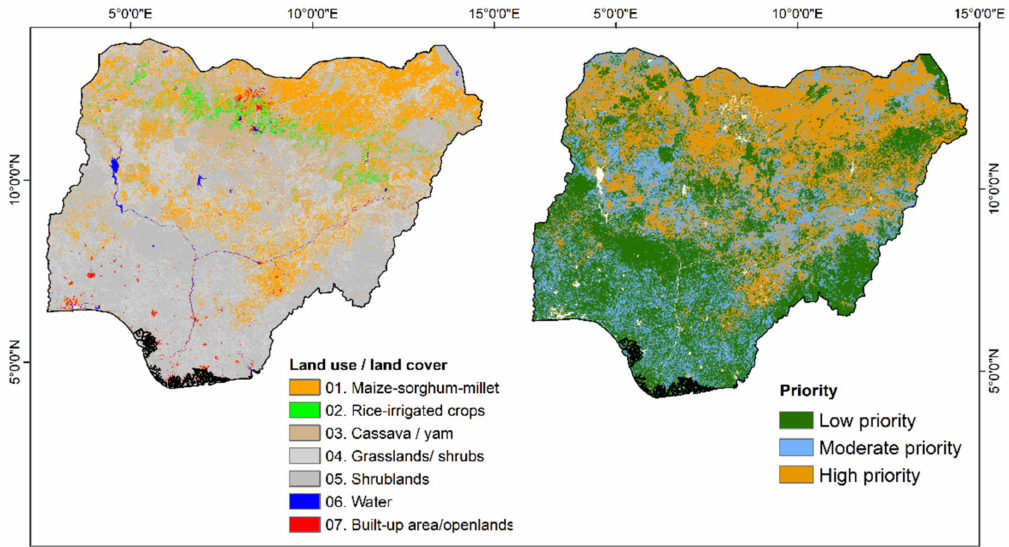
Figure 3. LULC classes in Nigeria.